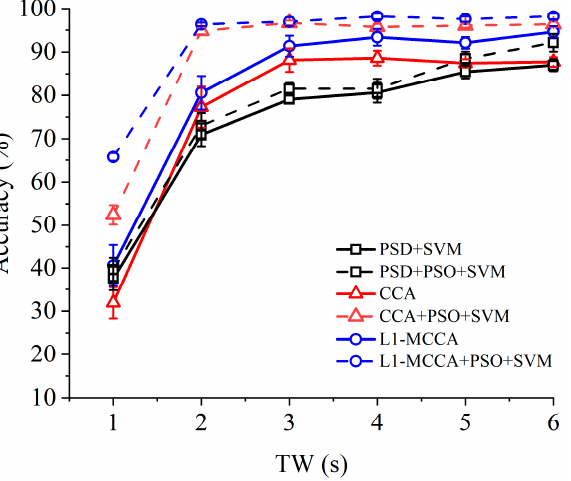
Figure 5. The group-averaged accuracies with different time window (TW) from 1 to 6 s for different methods. Error bar represents the standard error of accuracy. The solid and the dotted lines represent the method before and after optimization.